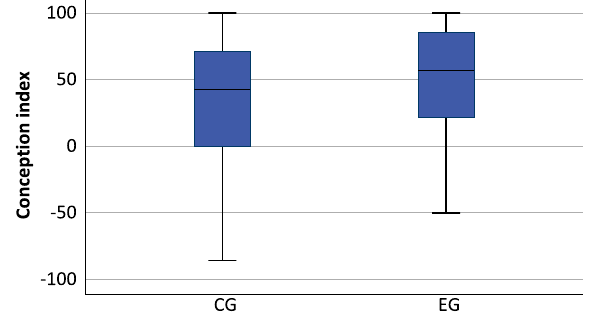
FIG. 10. Distribution of the post-test values of the conception index for the scale probability interpretation of quantum physics in CG and EG (cf. Table